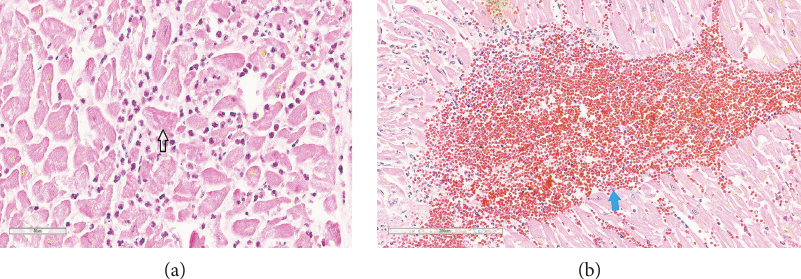
Figure 4: (a) Microscopic pathology. Acute myocardial infarction, H&E, 400x. Note: neutrophilic in fi ltration of the myocardium, with contraction bands (arrow). (b) Myocardium, H&E, 400x, showing intraventricular haemorrhage (blue arrow).